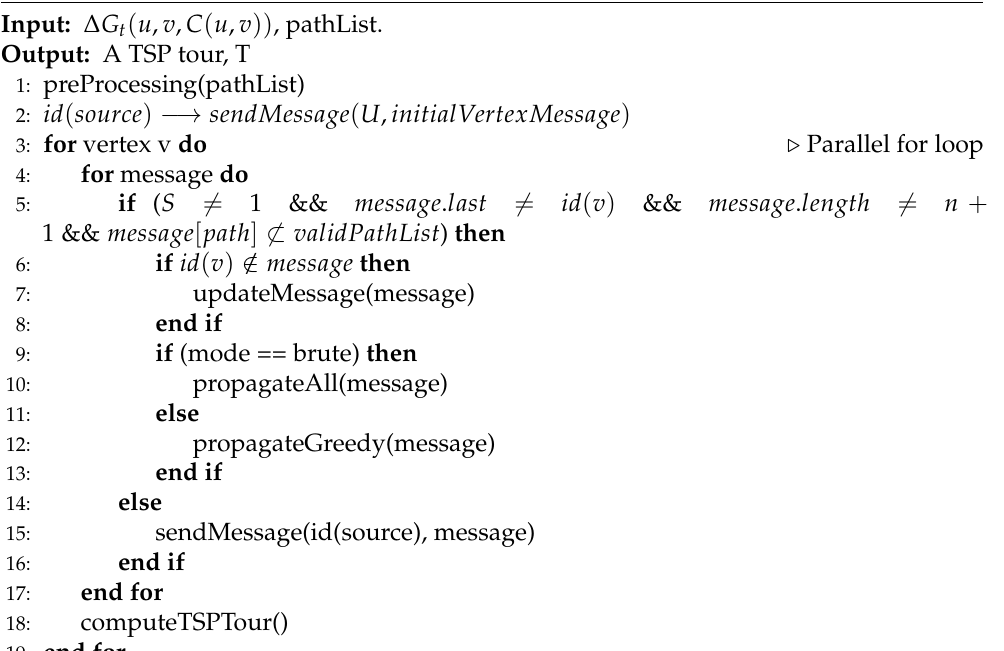
Algorithm 1 Incremental distributed TSP Algorithms: I-TSP and Ig-TSP